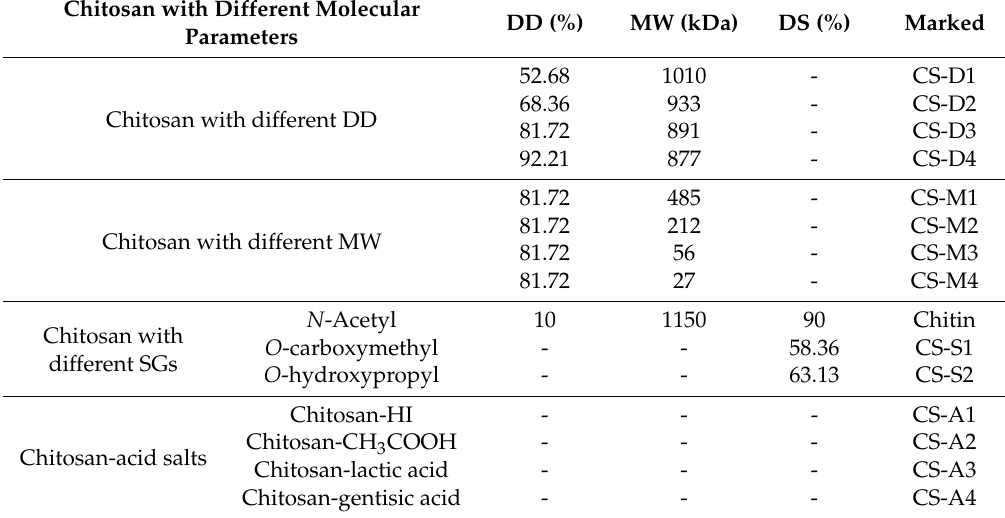
Table 1. Chitosan with different molecular parameters. DD: degree of deacetylation; MW: molecular weight; DS: degree of substitution; SGs: substituent groups; CS: chitosan. Chitosan with Different Molecular